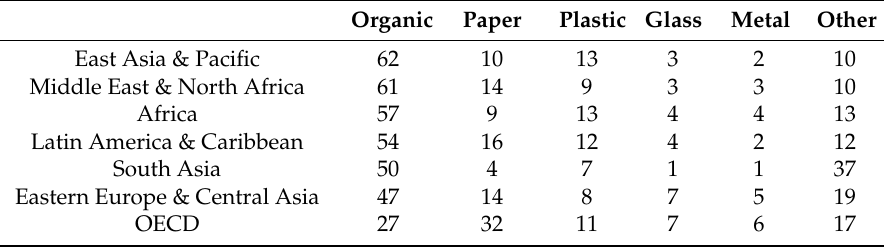
Table 1. Regional variation of Municipal Solid Waste (MSW) composition percentage [2]. Organic Paper Plastic Glass